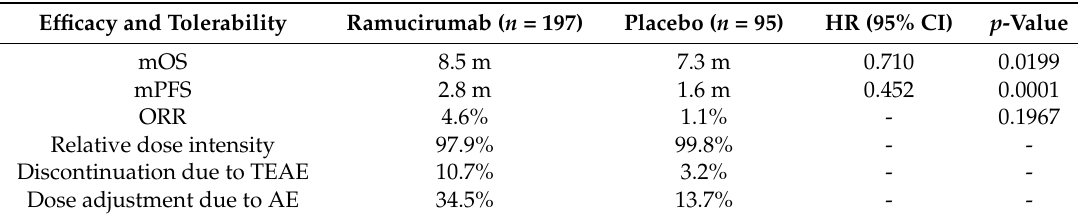
Table 3. Results of the REACH-2